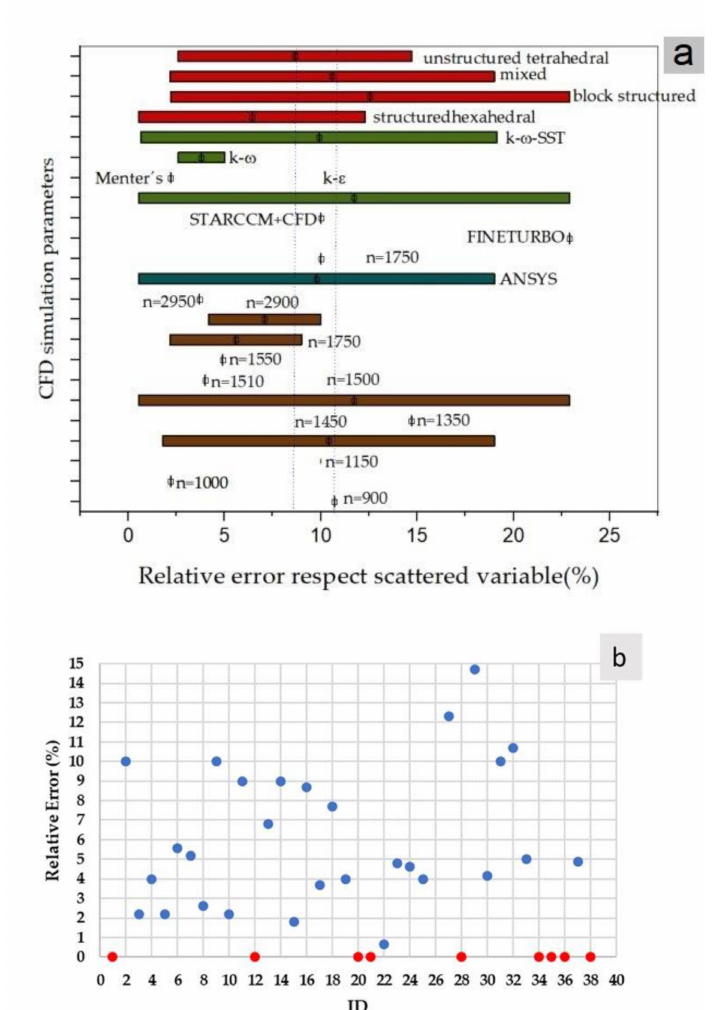
Figure 5. ( a ) Error analysis as a function of CFD parameters; ( b ) Error analysis as a function of relative error and ID (red points indicate the data is not available in the research or it cannot be